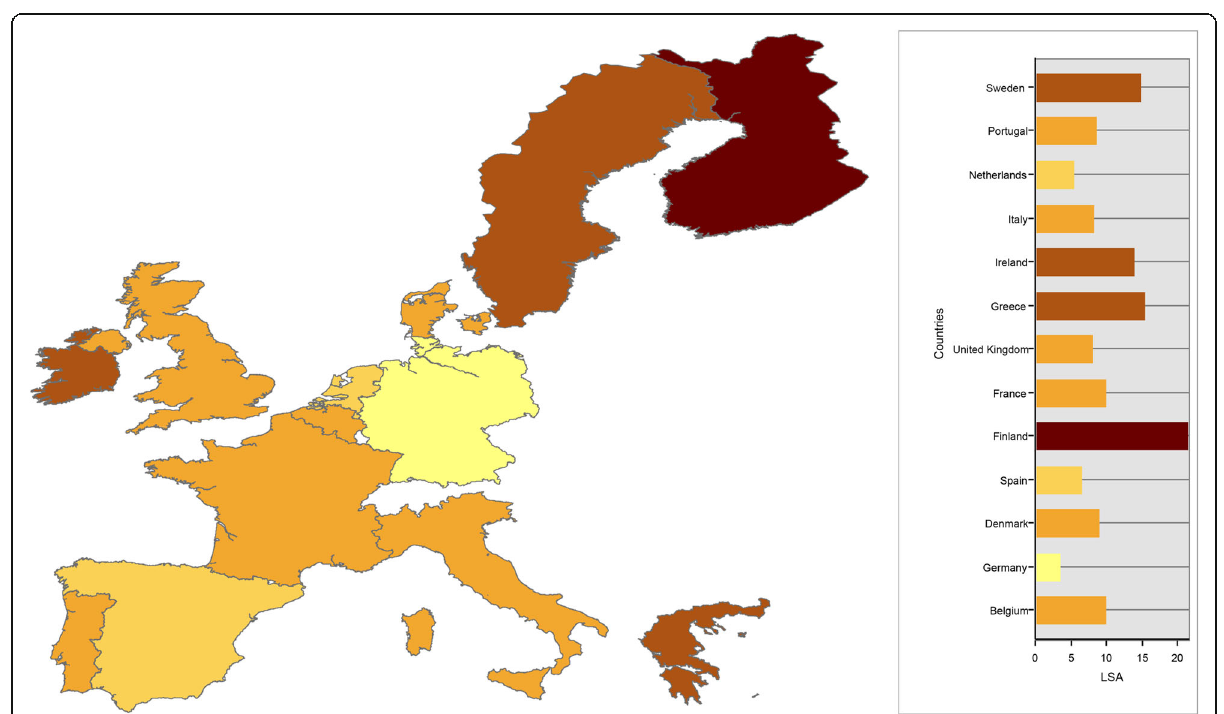
Fig. 15 The weighting of LSA Code deficiencies for EU15 countries as a result of AHP